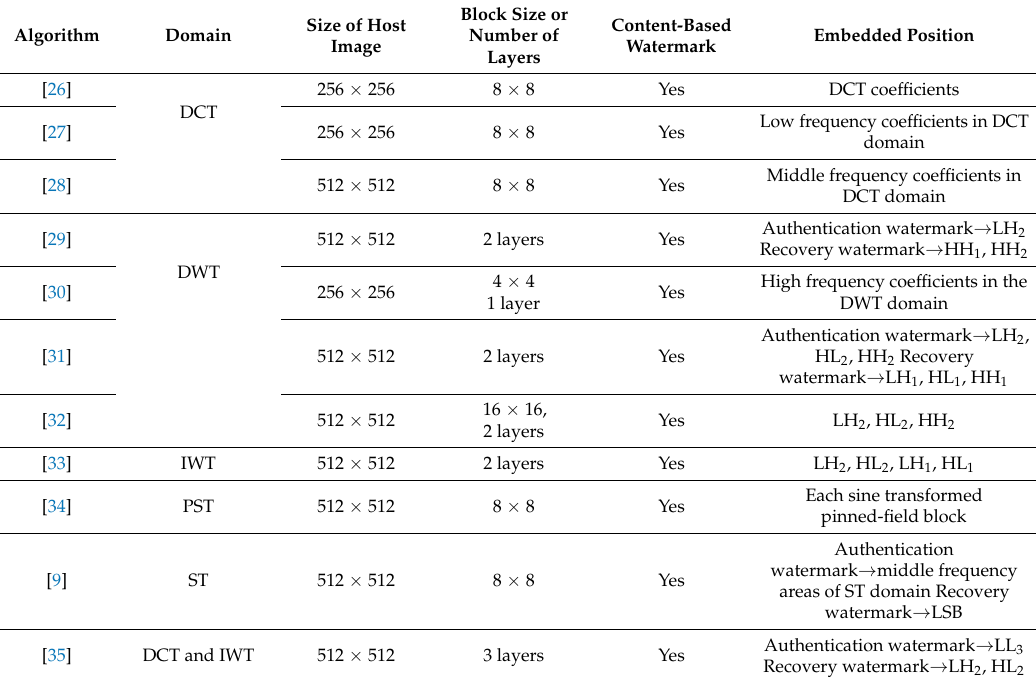
Table 3. Basic information of various recoverable algorithms.